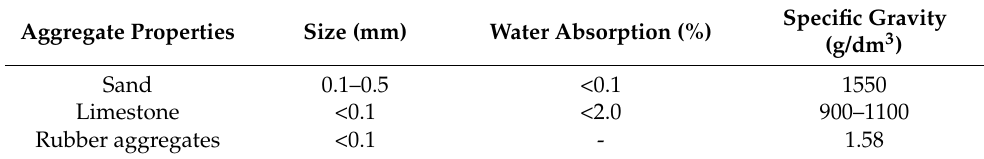
Table 1. Parameters of used aggregates.